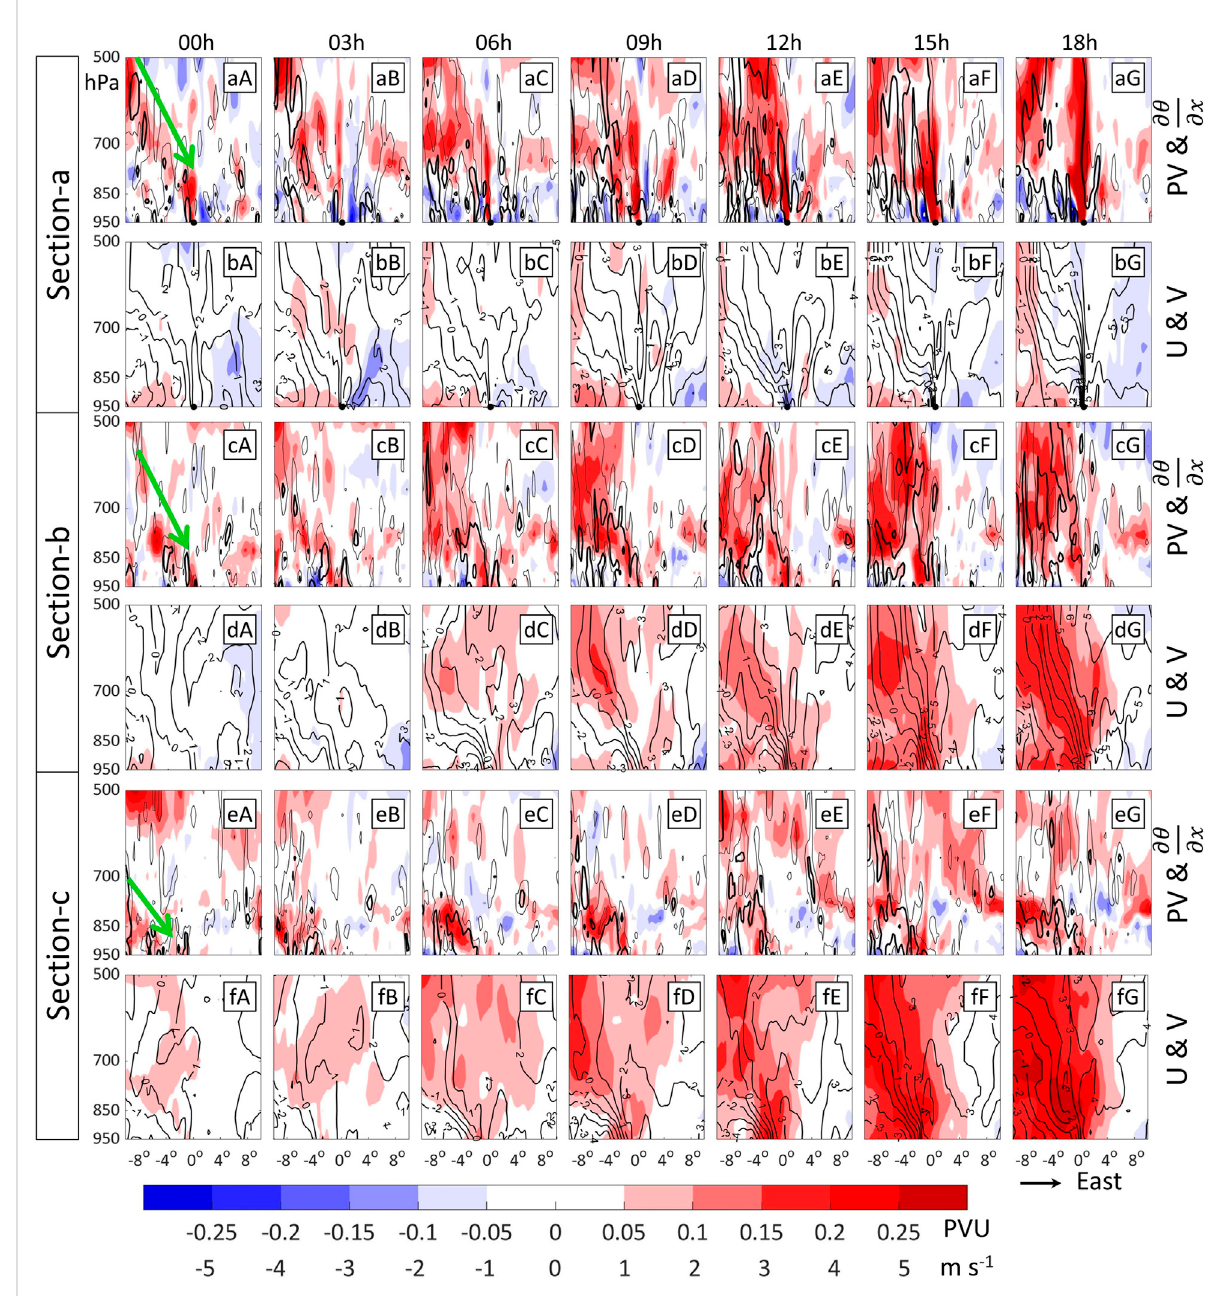
FIGURE 9 Difference in dynamicand thermal dynamic structures between ECs and OCs atthe three zonal cross sections shown in Figure 8E during initial development. Each section connects the west and east boundaries of the 20 ° ×20 ° box around cyclone centers. The fi rst/third/ fi fth row shows differences in PV (shadings) and z θ z x (contours) at section-a/b/c. Thick and thin contours denote z θ z x for ECs 4×10 − 6 K m − 1 and 2×10 − 6 K m − 1 larger than OCs, respectively. The second/fourth/sixth row shows differences in the zonal wind speed (shadings) and meridional wind speed (contours; unit: m s − 1 ) at section-a/b/c. The time (after the cyclones are identi fi ed) for each column is marked at the top. Black dots locate the cyclone centers. Green vectors in (aA) , (cA) , and (eA) show the approximate directions of PV